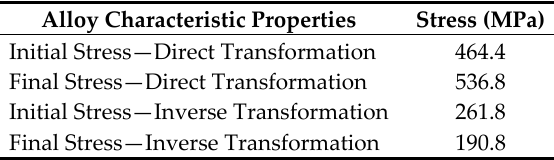
Table 2. Properties obtained by the cyclical